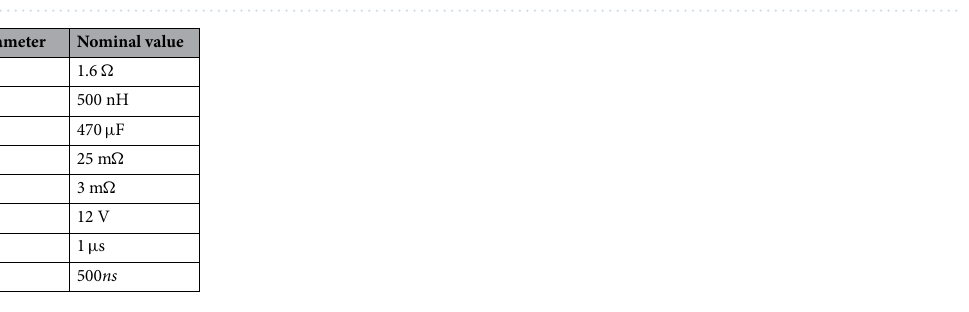
Figure 9. Buck Converter with Digital Control.